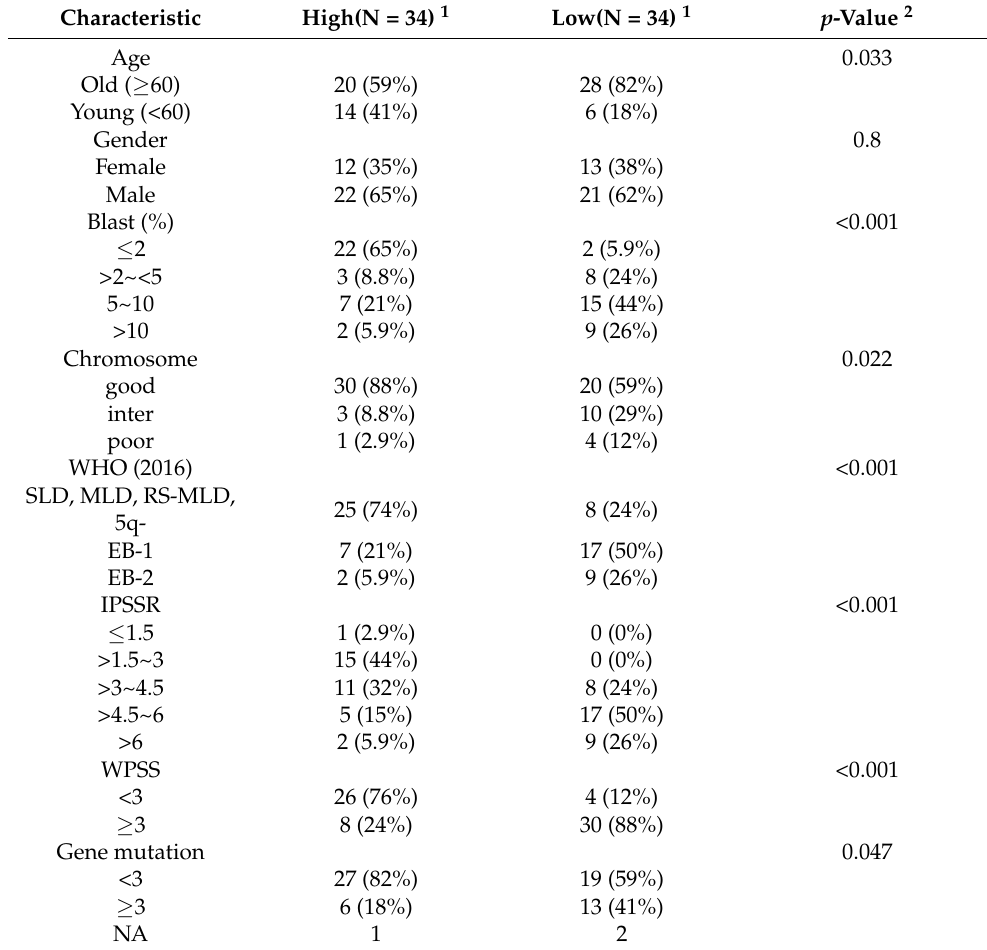
Table 2. FOXO1 expression in association with standard clinicopathological variables in